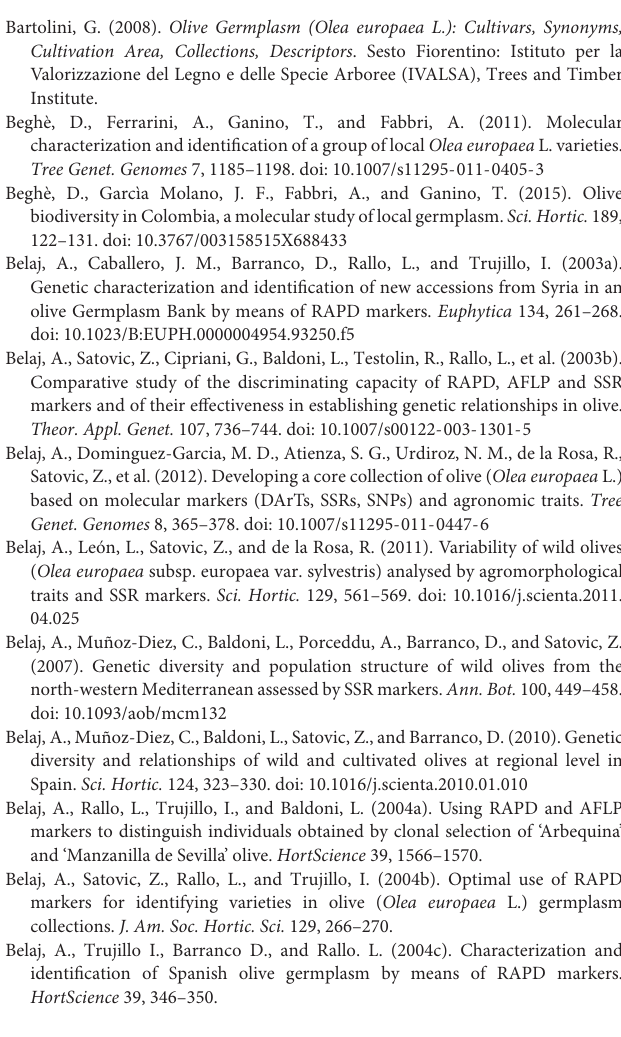
FIGURE S1 | The NJ dendrogram including all cultivated plant material analyzed in the